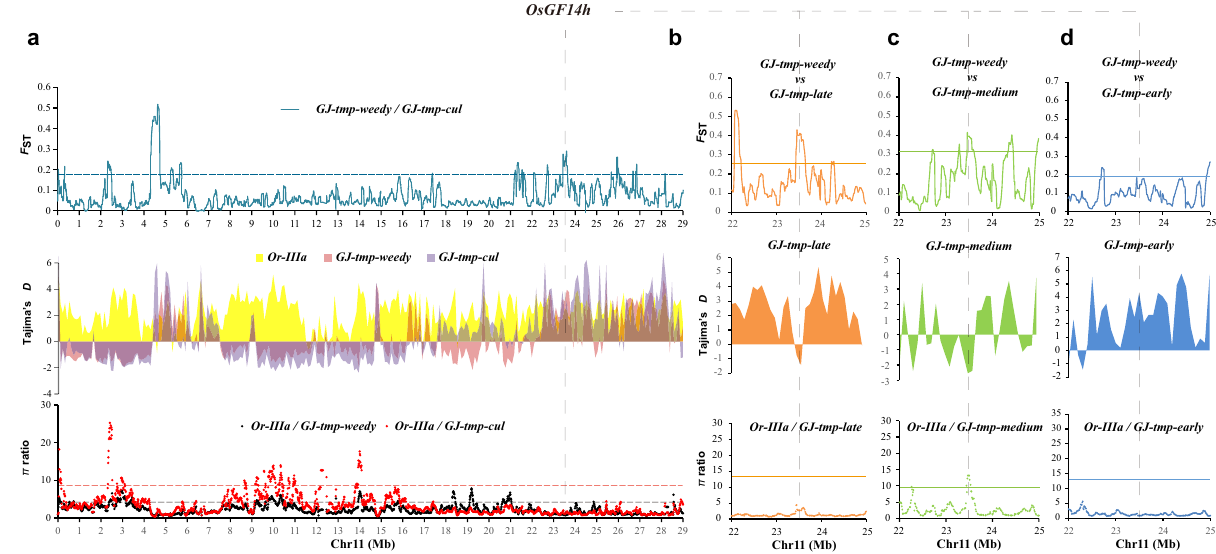
Fig. 6 | Genomic differentiation and selection between cultivated rice and weedy rice for OsGF14h in temperate japonica planting areas. a The top spec- trum shows population differentiation between ecotypes of GJ-tmp-weedy and GJ- tmp-cul . The y axis represents 100kb window-based F ST values. The horizontal dotted line corresponds to a 0.05 signi fi cance level of F ST value (0.1842). The middle spectrum shows 500kb window-based Tajima ’ D values of GJ- tmp-weedy , GJ-tmp-cul , and Or-IIIa , respectively. The bottom spectrum shows selection sweeps de fi ned by 100kb window-based π ratios of Or-IIIa divided by GJ-tmp-weedy (black dot) and Or-IIIa divided by GJ-tmp-cul (red dot), respectively. Red and black